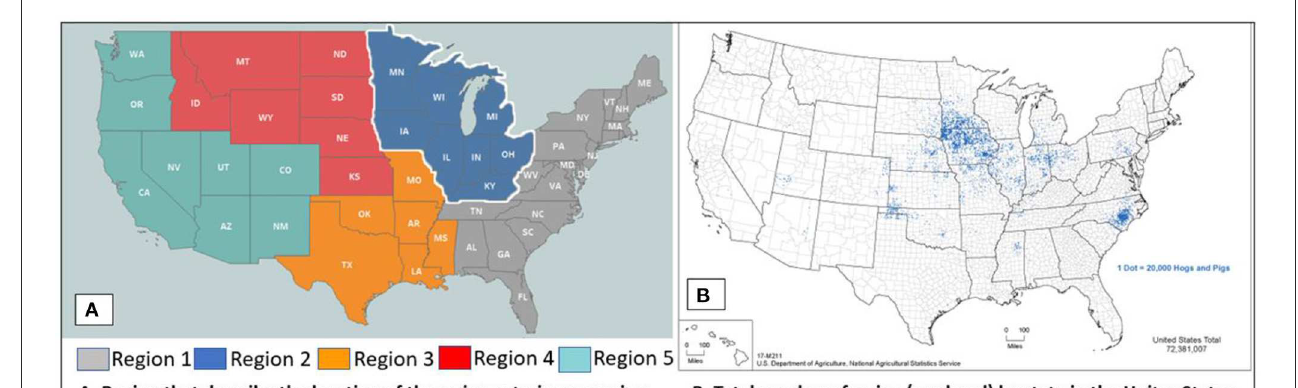
FIGURE1 Regions represented by the influenza A virus veterinarian survey respondents (A) and relationship to the density of swine located in the United States (B) . * (B) Inventory of hogs and pigs from Census of Agriculture (11).